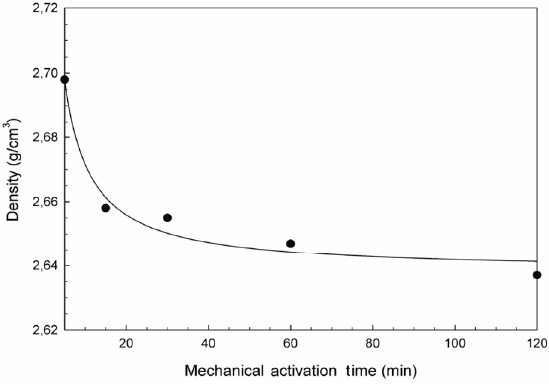
Fig. 7 Density change of the powder mixture as function of the mechanical activation duration.